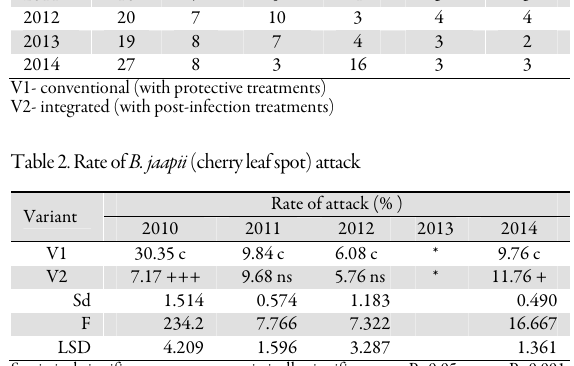
Density, number flies caught in one trap